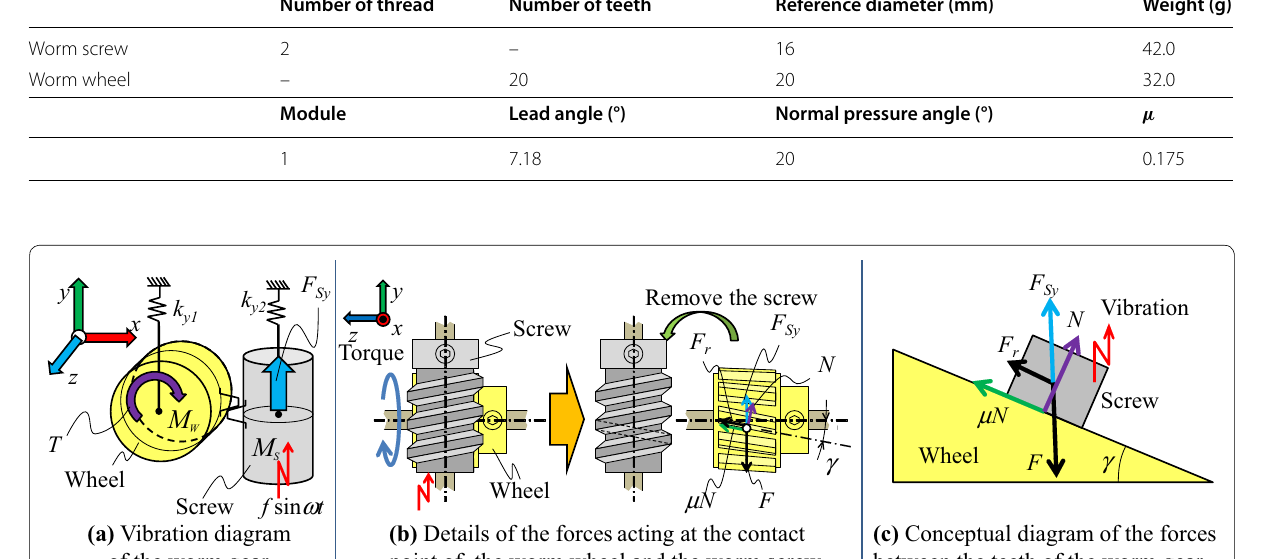
(c) Conceptual diagram of the forces between the teeth of the worm gear.